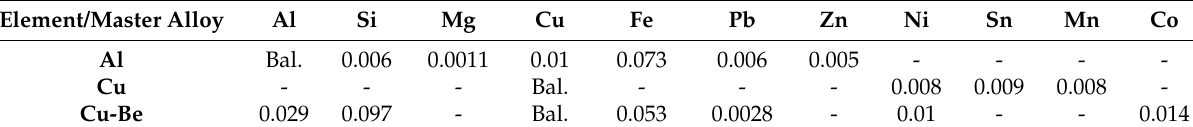
Table 1. Chemical compositions (wt.%) of the elements and of the Cu-Be master alloy used in the preparation of the alloys.